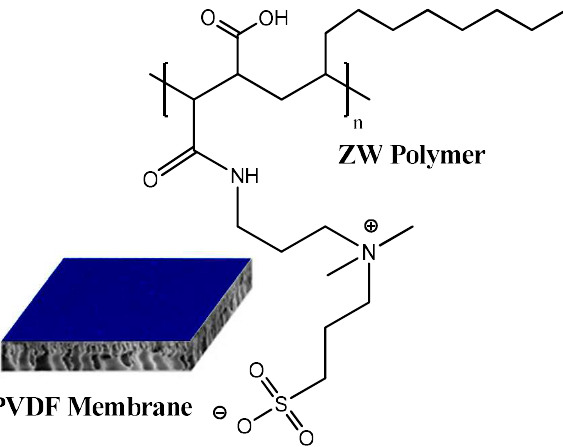
Figure 1. The structure of PVDF membrane modified with ZW polymer